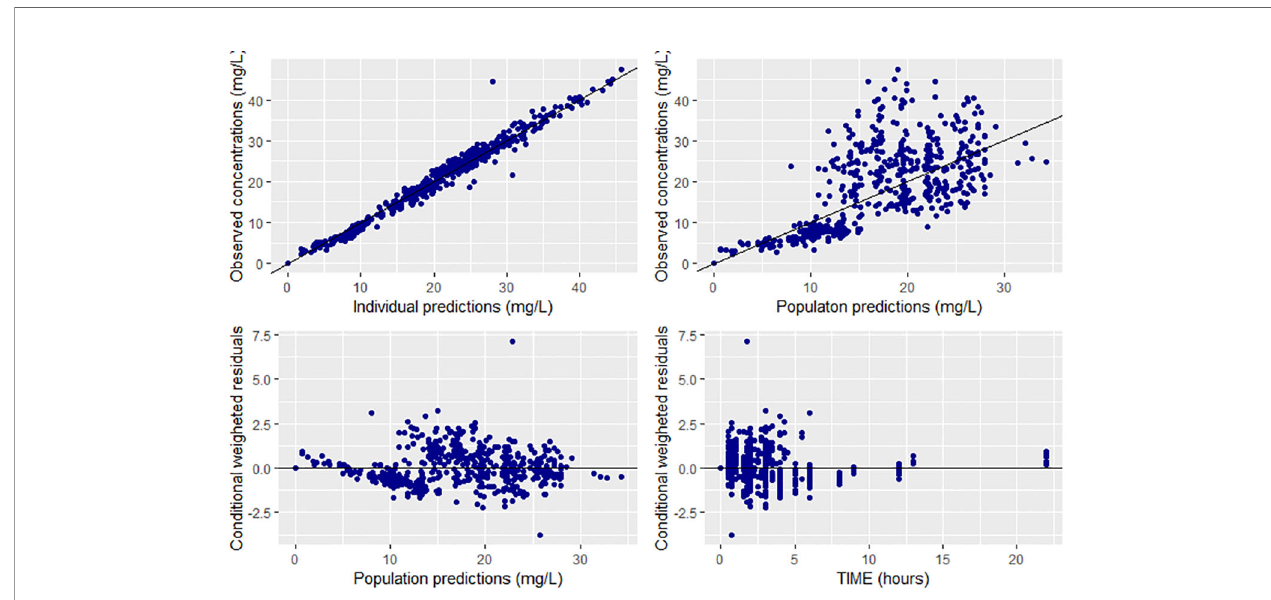
FIGURE 1 | Goodness of fi t plots for the fi nal population PK model of CPA (prediction-based (top panel) and residual based (bottom panel) goodness of fi t